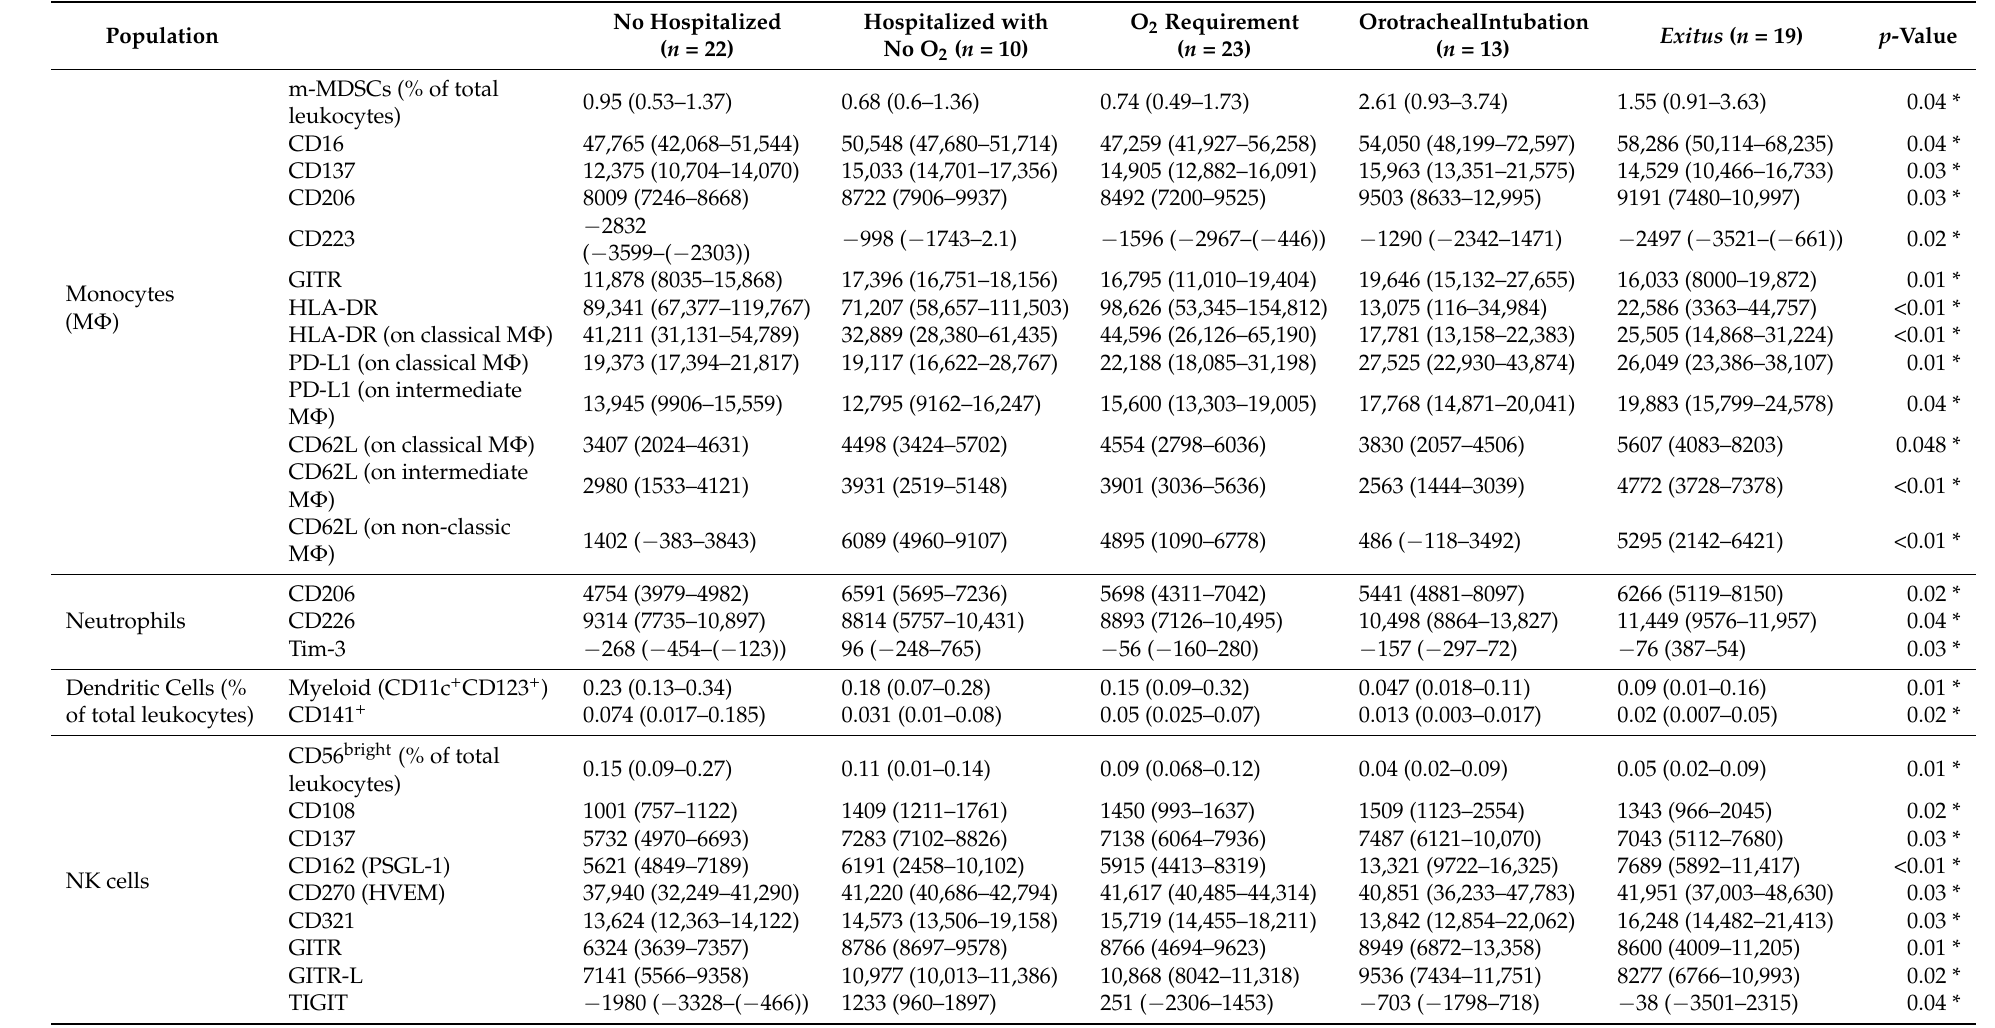
Table 1. Immune subpopulations, immune checkpoints and activation markers’ expression at admission in COVID-19 patients classified according to their severity and final